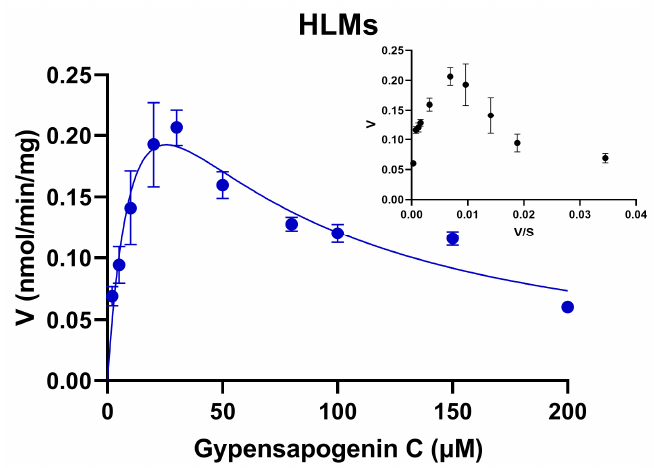
Figure 3. Enzyme kinetic profile of GPC in HLMs. Table 1. Kinetic parameters for determination of GPC glucuronidation in HLM, RLM, MLM, DLM, RaLM, BLM, PLM, and MkLM.